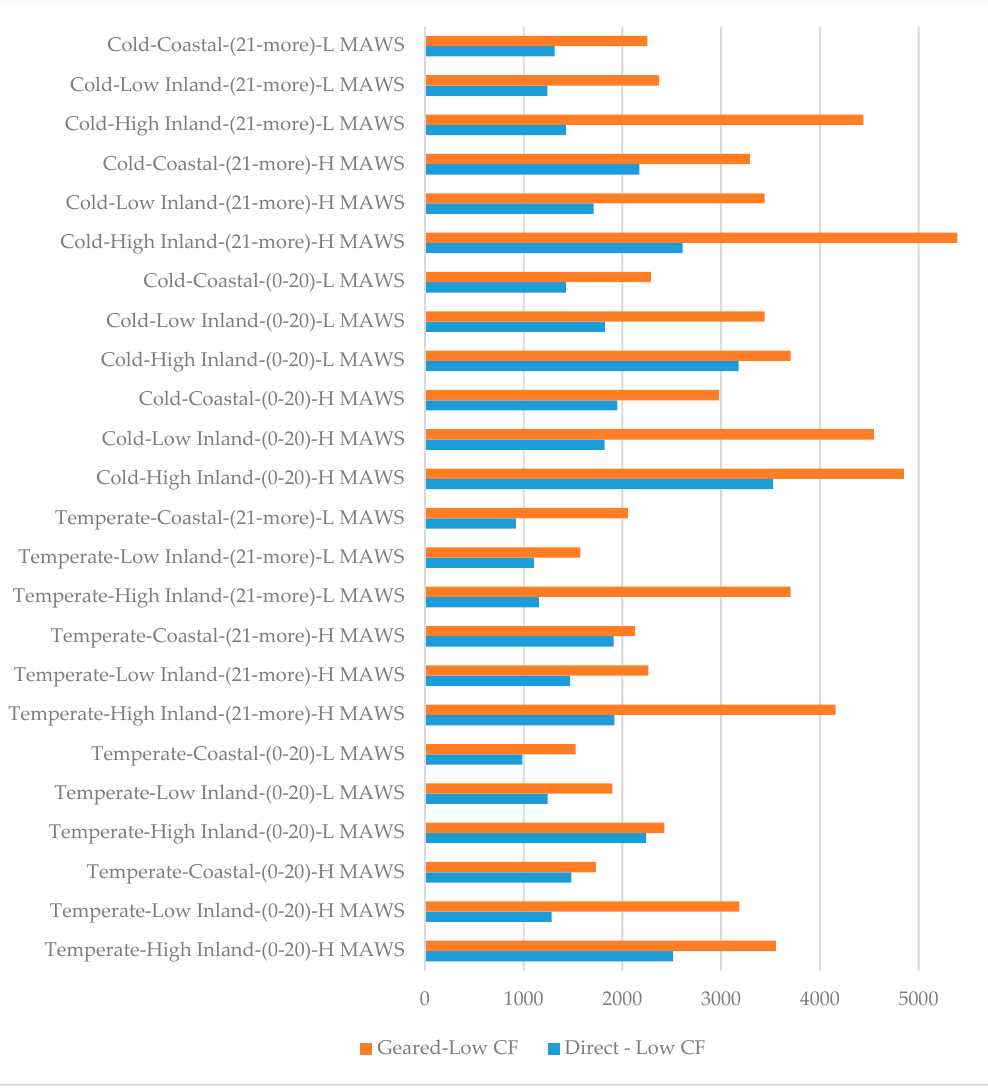
Figure 5. Predicted cost of failures at locations with low capacity factor.